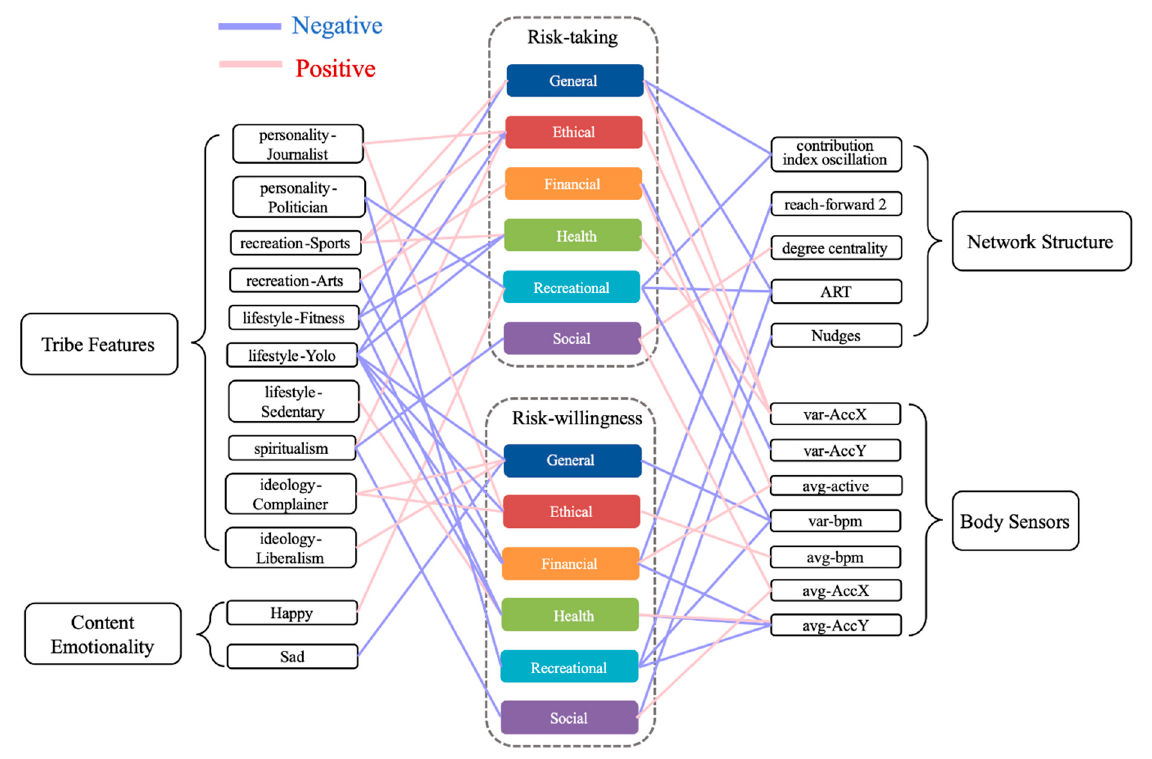
Figure 4. Significant predictors of risk-preference.